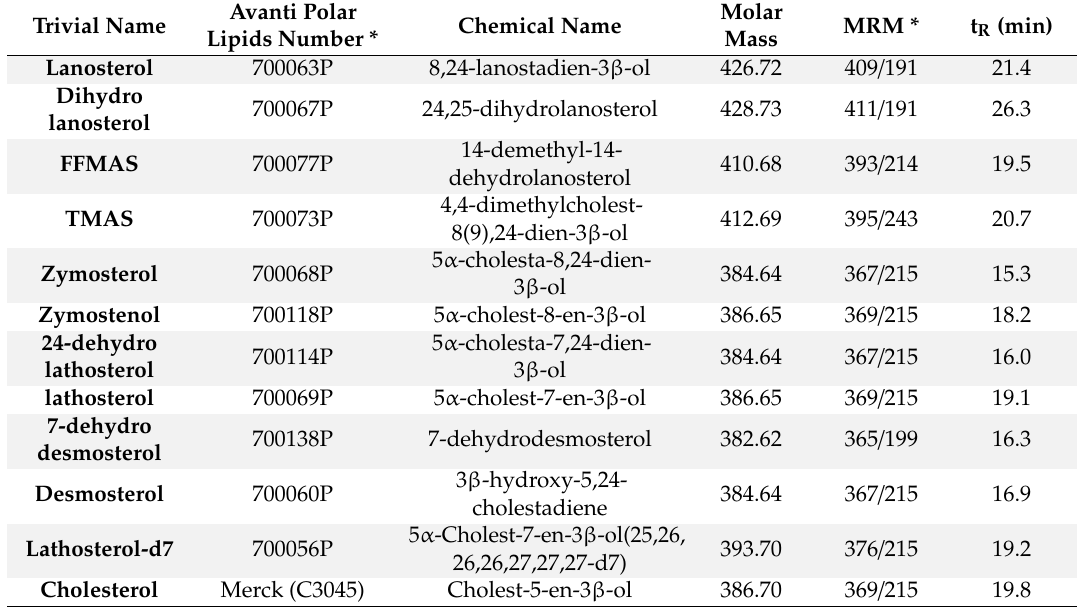
Table 3. MS detection conditions and retention